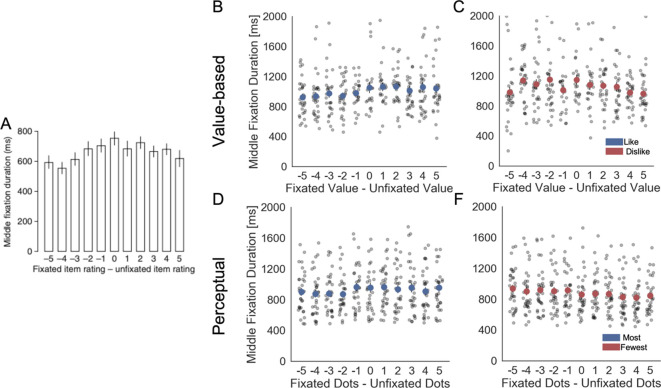
Fixation properties: middle fixation duration as a function of the difference in ratings (value or number of dots) between the fixated and unfixated items.(A) Krajbich et al., 2010 reported a slight but significant dependency of middle fixations durations on the difference in value between items. In our Value Experiment, we found that in like (B) and dislike (C) this relationship was significant (hierarchical linear regression estimate: βLike = 0.015, t(28.22) = 2.192, p<0.05; βDislike = -0.027, t(28.22) = -4.415, p<0.001). Similarly, in the Perceptual Experiment, most (D) and fewest (F) frames, the dependence was found also significant (βMost = 0.01, t(29.51) = 2.663, p<0.01; βFew = -0.027, t(29.51) = -6.330, p<0.001). Interestingly, a positive sign of the effect in like and most frames indicates that middle fixations tend to be longer for the option with the higher value or number of dots. On the other hand, the negative sign of the effect indicates that middle fixations would be longer for the option with lower value or number of dots in dislike and fewest frames. Light grey dots correspond to individual participants’ middle fixation durations for each bin. Full red or blue circles indicate participant’s average. Data are binned across participants for visualisation. All the factors and the predicted variable in the hierchical regression were z-scored at participant level. Panel A reproduced from Krajbich et al., 2010.